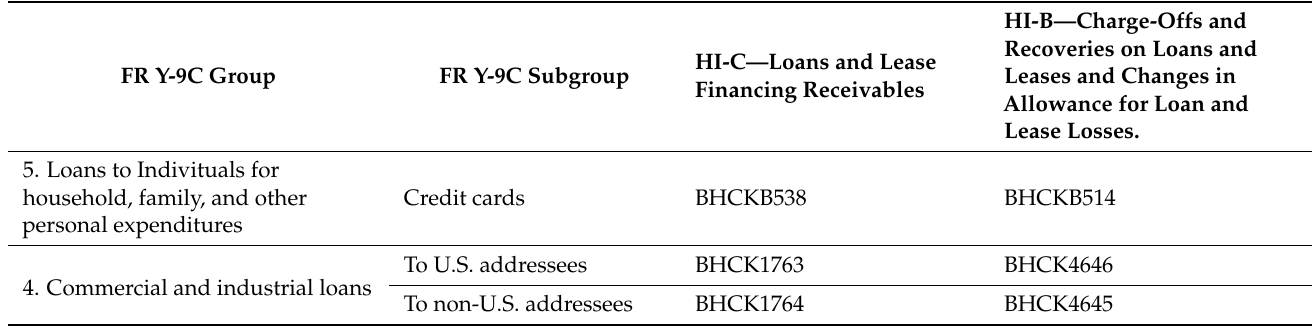
Table 3. The Items codes (FR Y-9C report).